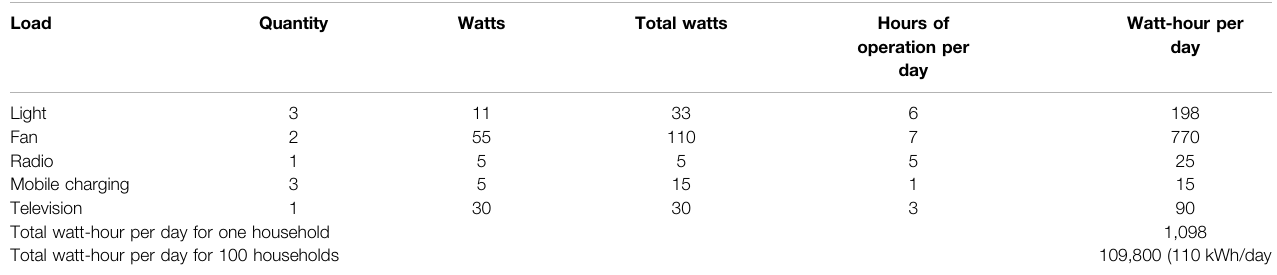
TABLE 5 | Load demand for a single